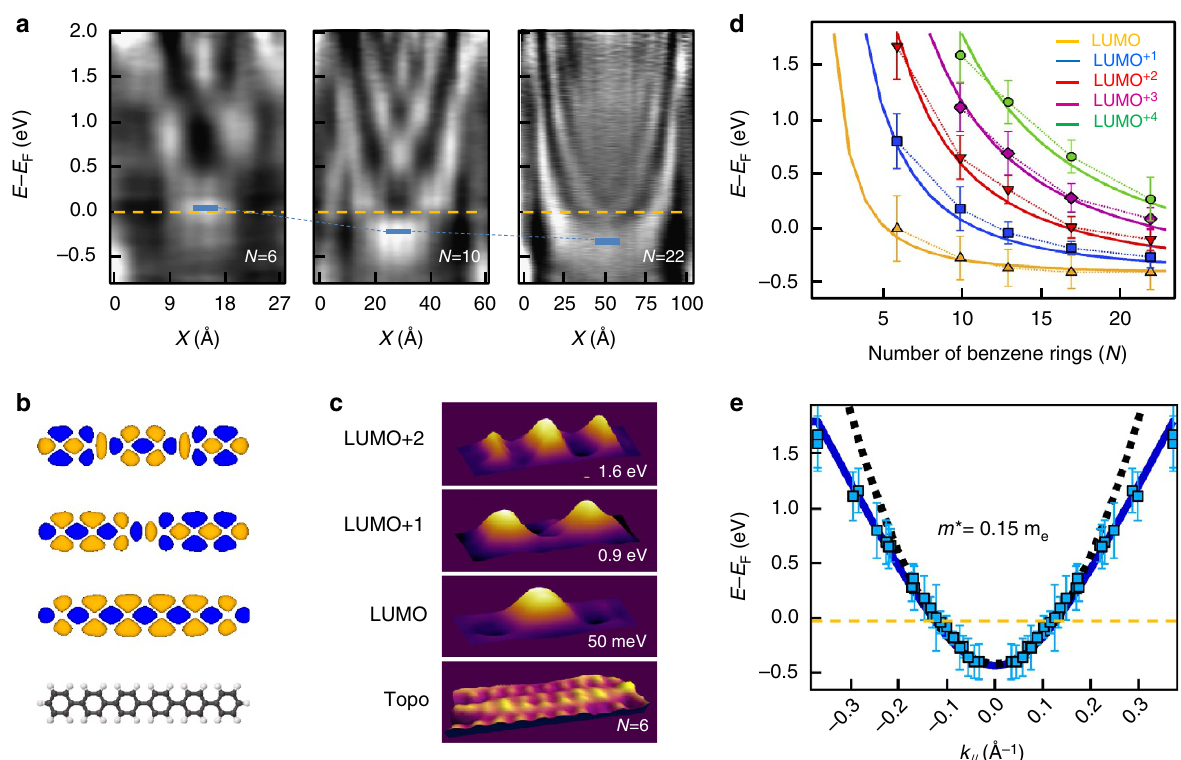
Figure 2 | Conduction band structure deduced by scanning tunnelling spectroscopy. ( a ) Experimental d I /d V measurements recorded along a polymer for three lengths ( N correspond to the number of phenyl rings). The vertical axis is energy, the horizontal axis is position along the polymer. The blue marks show the bottom of the bands. ( b ) Schematic representation of the free sexiphenyl molecule and its LUMO, LUMO þ 1 and LUMO þ 2 states calculated using a tight-binding model built from Hu¨ckel orbitals. ( c ) Experimental topography (bottom) and STS conductance maps for the N ¼ 6 case. ( d ) Experimental (dots) and theoretical (solid lines, extracted from Hu¨ckel’s model) evolution of the energy of the LUMO states as function of the length of the polymeric chains. Error bars are given by the s.d. extracted from Gaussian fits (Supplementary Fig. 4). ( e ) Experimental and theoretical dispersion of the LUMO conduction band. Experimental points (blue) are extracted from data shown in d , using the relation k // ¼ 2 p p /Na ( p ¼ 1,2, y ). The theoretical band (blue solid line), is obtained from a tight-binding model using the same resonance integral as the Hu¨ckel model. The black dashed curve represents a parabolic dispersion with m * ¼ 0.15 ± 0.02 m e . In d and e , absolute positions of calculated bands have been shifted by 1.9eV towards occupied states to match the experimental